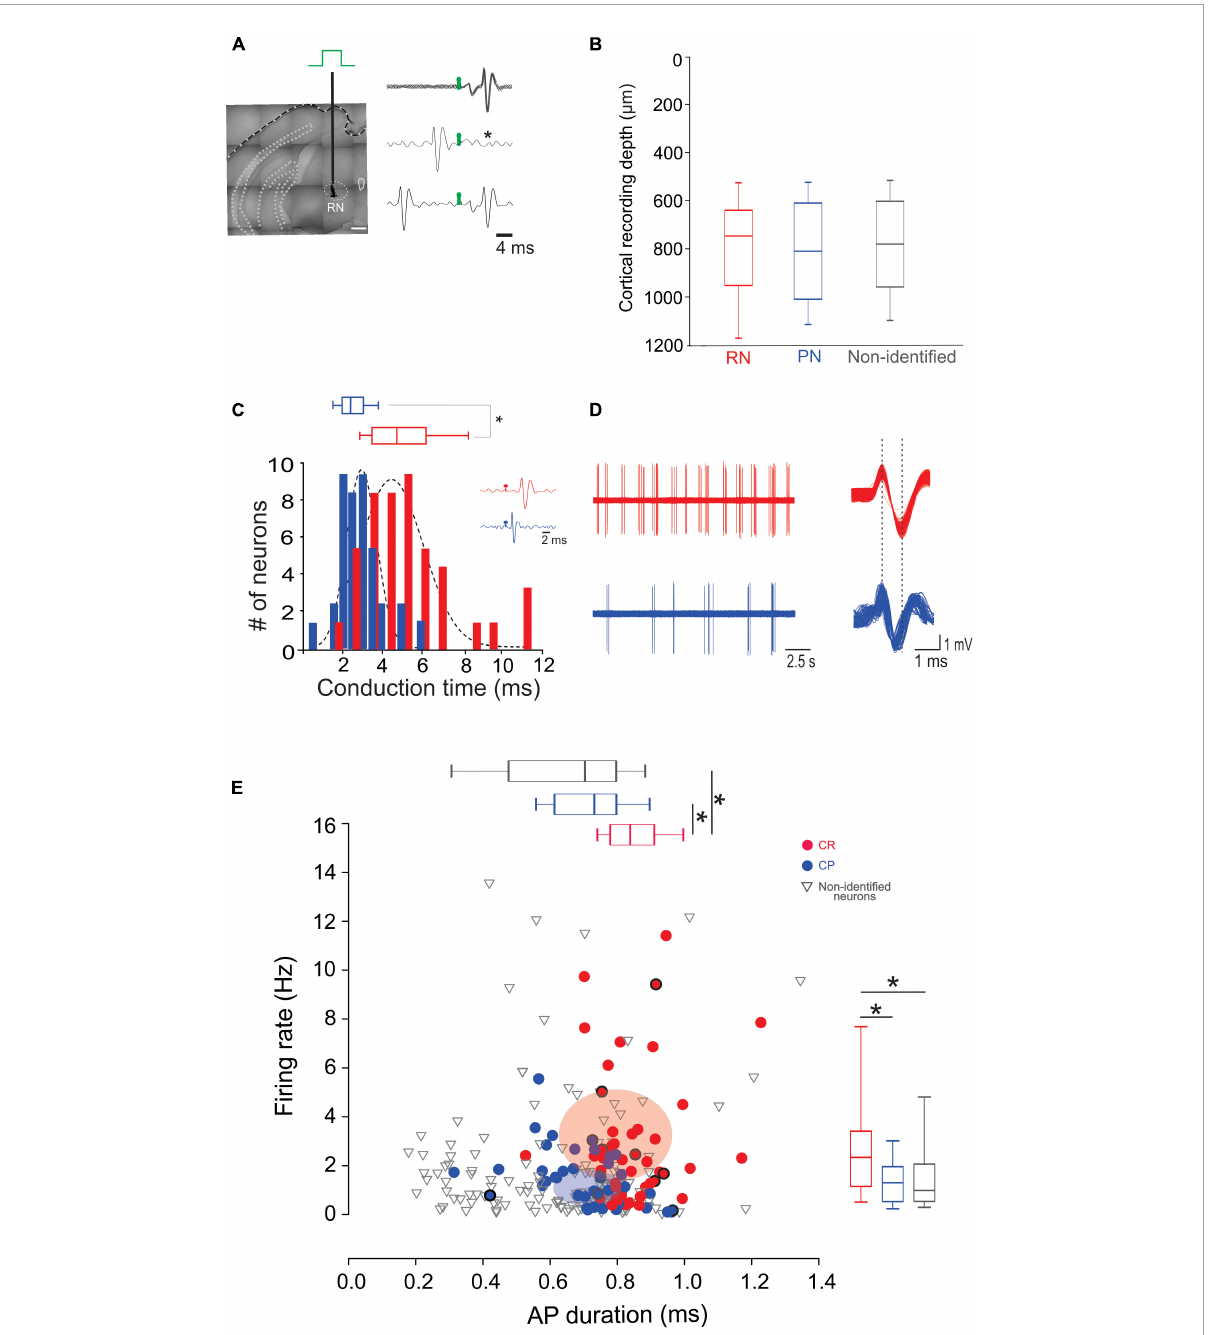
FIGURE2 CR and CP PTNs exhibit distinct electrophysiological characteristics in vivo . (A) PTNs were identified by collision tests. A stimulating electrode was placed in the RN or PN to stimulate the CR or CP terminals. The representative traces show superimposed electrophysiological antidromic responses evoked by the ipsilateral RN (upper trace) showing that action potentials appear with a fixed latency (stimulation artifact in green). The middle trace shows the collision test when an orthodromic action potential occurs below the antidromic latency. The asterisk indicates the point at which the antidromic response would have occurred. The third trace shows that when the orthodromic action potential occurs above the antidromic latency, the collision of antidromic response does not occur. (B) Comparison between the recording depths obtained for PTNs projecting to RN, PN and non-identified neurons. (C) Distribution of antidromic conduction time of CR (red) and CP (blue) neurons showing that neurons projecting to the RN conduct significantly faster (* p < 0.05, Mann-Whitney). Two exemplary traces shown in the inset. (D) Representative electrophysiological recordings of spontaneous activity of CR (left upper trace) and CP (left lower trace). Aligned action potentials of the same neurons are also shown (right traces). (E) Relationship between action potential (AP) duration (peak to valley) and spontaneous firing rate of all recorded neurons (CR n = 45; CP n = 42; non-identified n = 154). Box plots show the distribution of AP durations (up) and firing rate (right). Ellipsoids in the graph represent the median (center) and standard errors (axis) of the data. * p < 0.05, One-way ANOVA, Dunn’s post-hoc test and Shapiro-Wilk